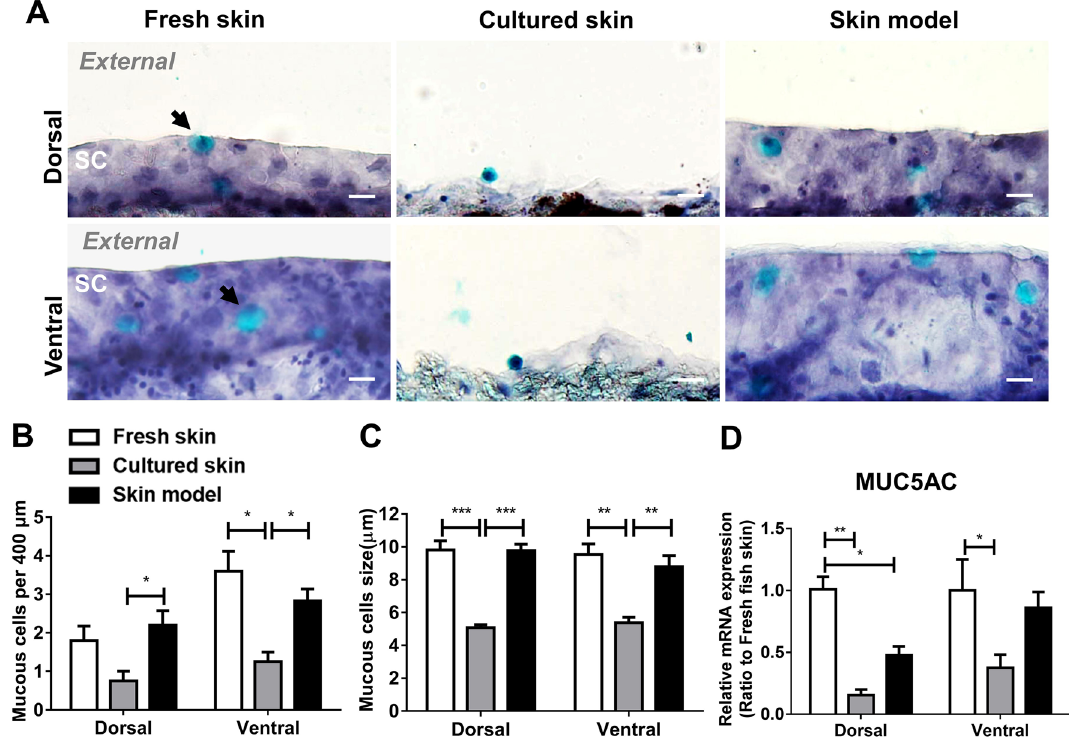
Figure 4. Morphometric analysis and mucin expression of goblet cell in the skin model. Samples from fresh skin, 5-day cultured skin, and skin model were cryo-preserved and sectioned. ( A ) Tissue sections of dorsal and ventral regions skin were stained with Alcian blue-hematoxylin stain. Arrows point the goblet cells located at superficial epithelial cell (SC) surface. Shown are representative images, Bar = 10 μm. Images were used to determine ( B ) the number and ( C ) average size of goblet cells. All data were shown as mean values (± SEM). Four fish and three replicates of tissue were used. The morphometric evaluation was determined from 20 randomly selected fields per sample in each condition. ( D ) MUC5AC expression was measured by RT-qPCR and compared relative to the expression in fresh skin. All data were shown as mean values (± SEM). Four fish and three replicates of tissue were used. Statistical significance was determined by using one-way ANOVA followed by Bonferroni post hoc test for comparison of expression between three conditions. ***p ≤ 0.001; **p ≤ 0.01; *p ≤